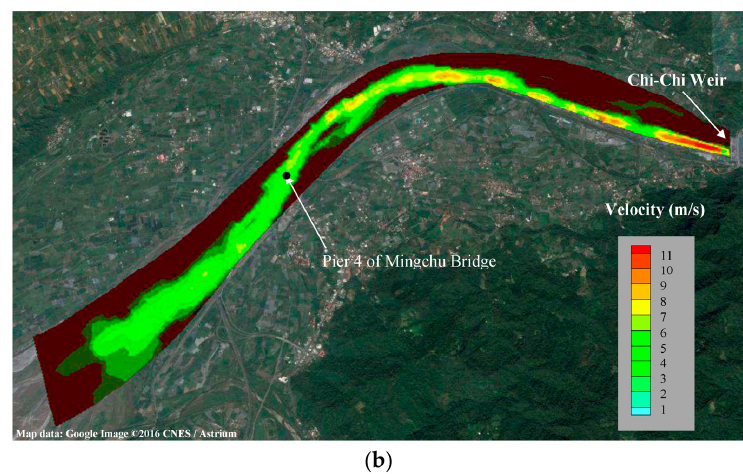
Figure 14. Simulated velocity contours in the study reach under peak-flood condition for ( a ) Monsoon and ( b ) Typhoon Matmo. Table 2. Comparisons of simulated water levels with measured results by using 2D finite-volume hydraulic model.